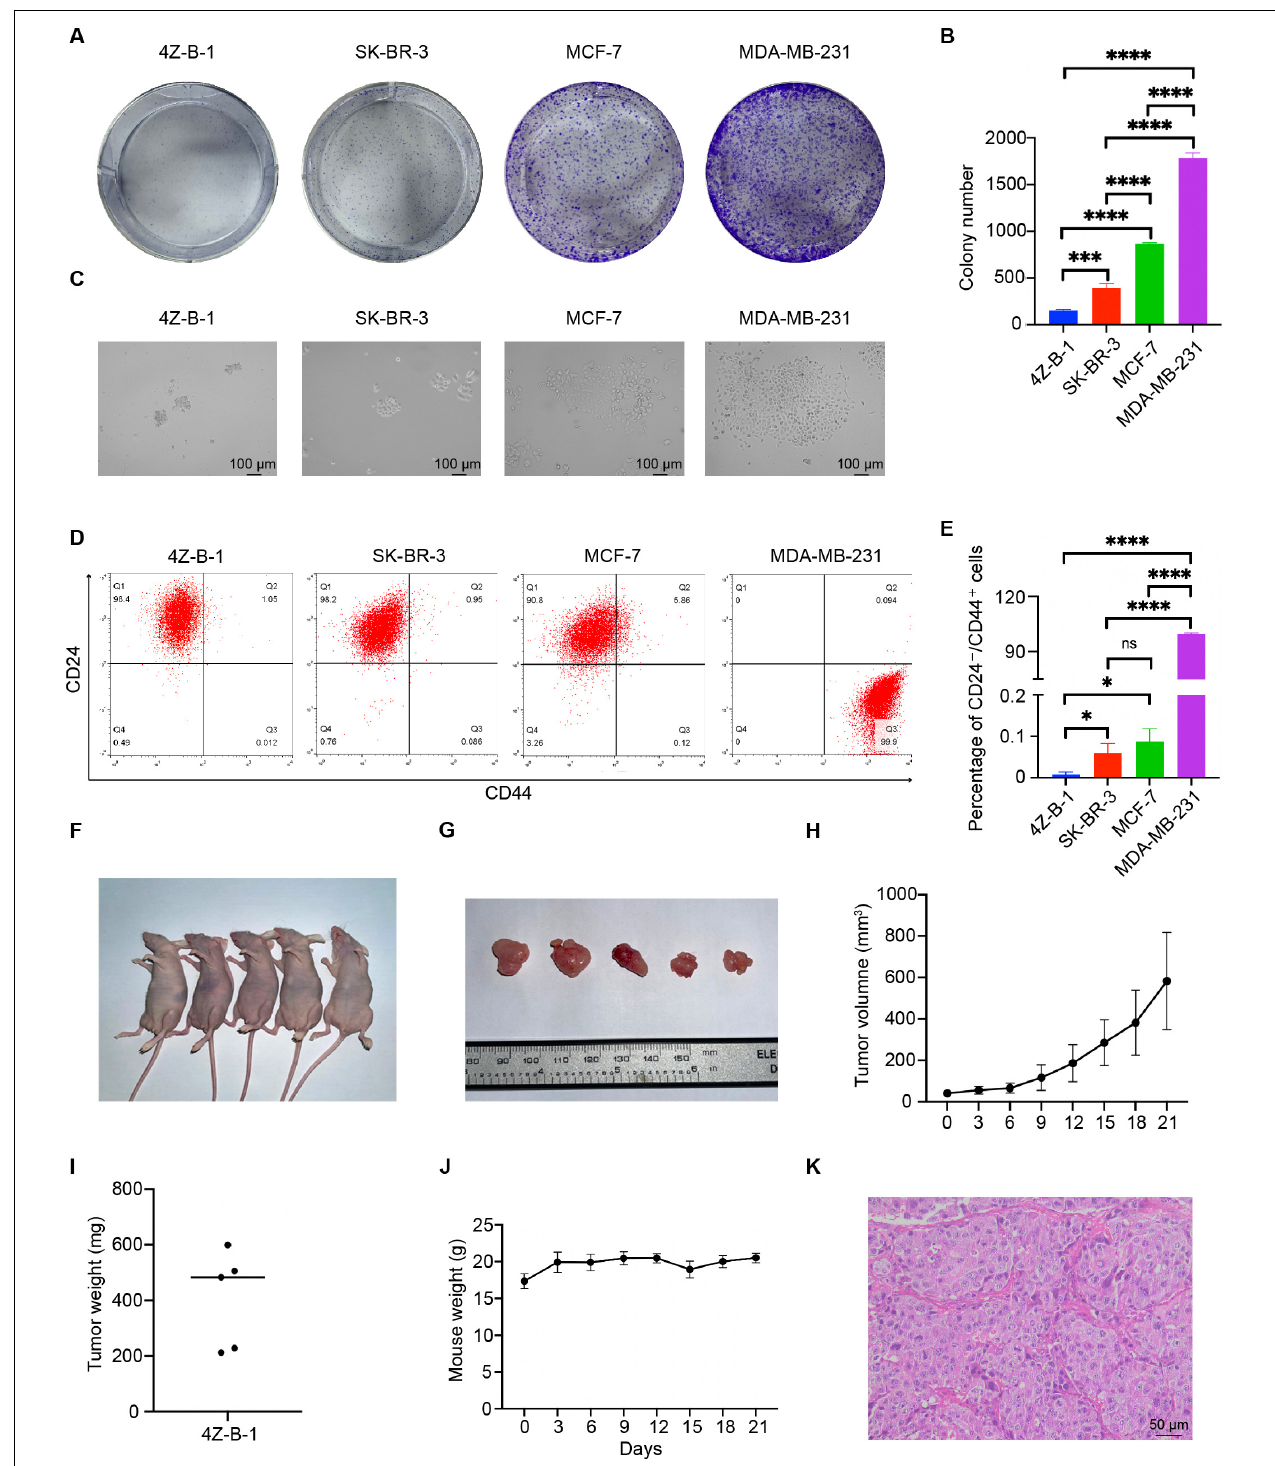
FIGURE 7 | Colony-forming capability, putative stemness and tumorigenicity in immunodeficient mice. (A,B) Colony-forming capability of the 4Z-B-1, SK-BR-3, MCF-7, and MDA-MB-231 cell lines and statistical analysis. (C) Morphology of colonies formed by 4Z-B-1, SK-BR-3, MCF-7, and MDA-MB-231 cells. (D,E) Percentage of CD24-/CD44+ cells among 4Z-B-1, SK-BR-3, MCF-7 and MDA-MB-231 cells and statistical analysis. (F,G) Tumor formation in immunodeficient mice (tumor size indicated by the ruler). (H) Tumor growth curves of 4Z-B-1 cells. (I) Weight of 4Z-B-1 cell xenografts. (J) Weight curve of the experimental mice. (K) H&E staining of 4Z-B-1 cells xenografts. ns, p > 0.05; * p < 0.05; *** p < 0.001; **** p < 0.0001. Magnification, (C) × 100; (K) × 200.